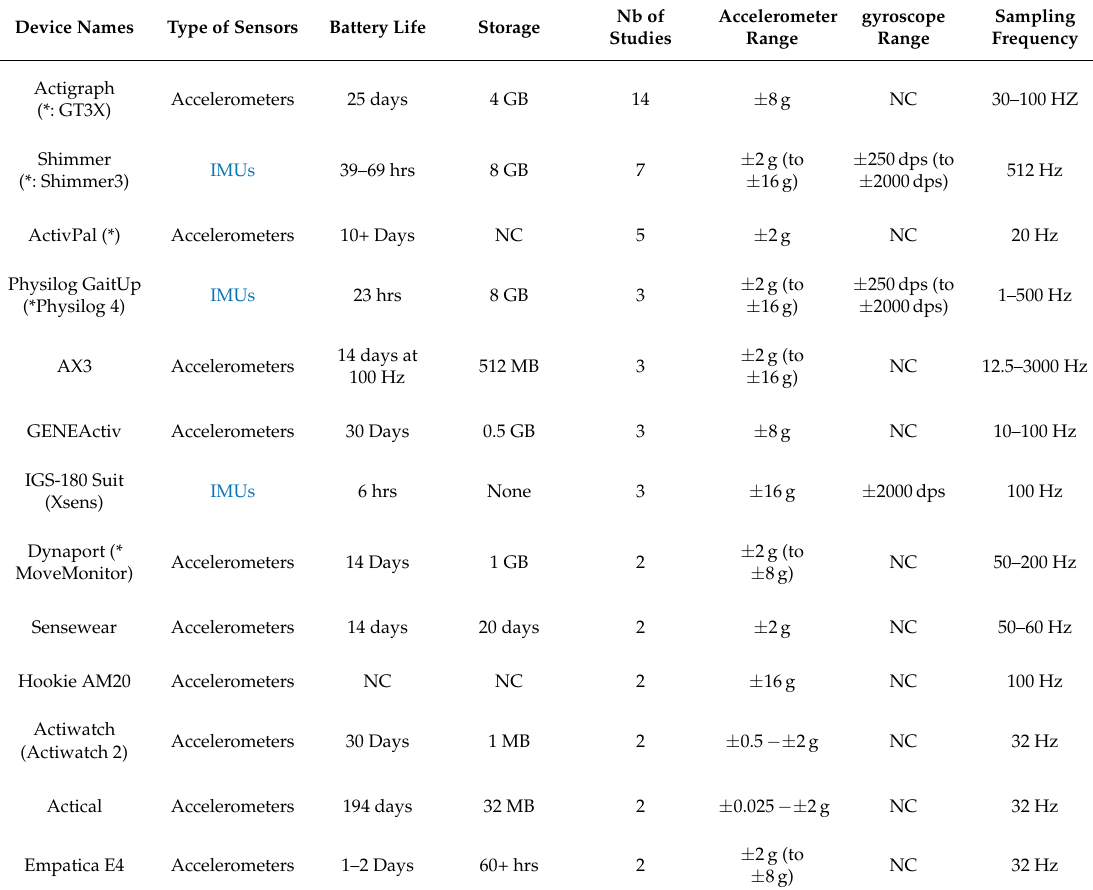
Table 2. Details of used inertial sensors. dps: degrees per